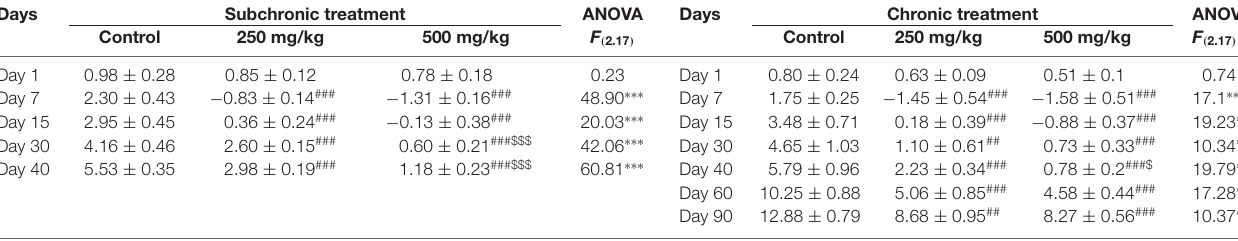
TABLE 1 | Subchronic and chronic effect of Glyphosate based herbicide (GBH) on body weight gain (g).